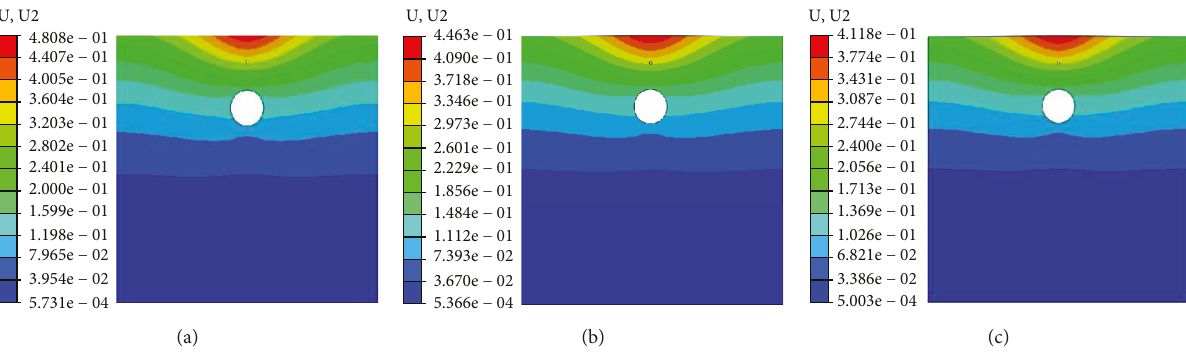
Figure 26: Surface subsidence under di ff erent water pressure (unit: m). (a) Condition 1; (b) condition 4; and (c) condition